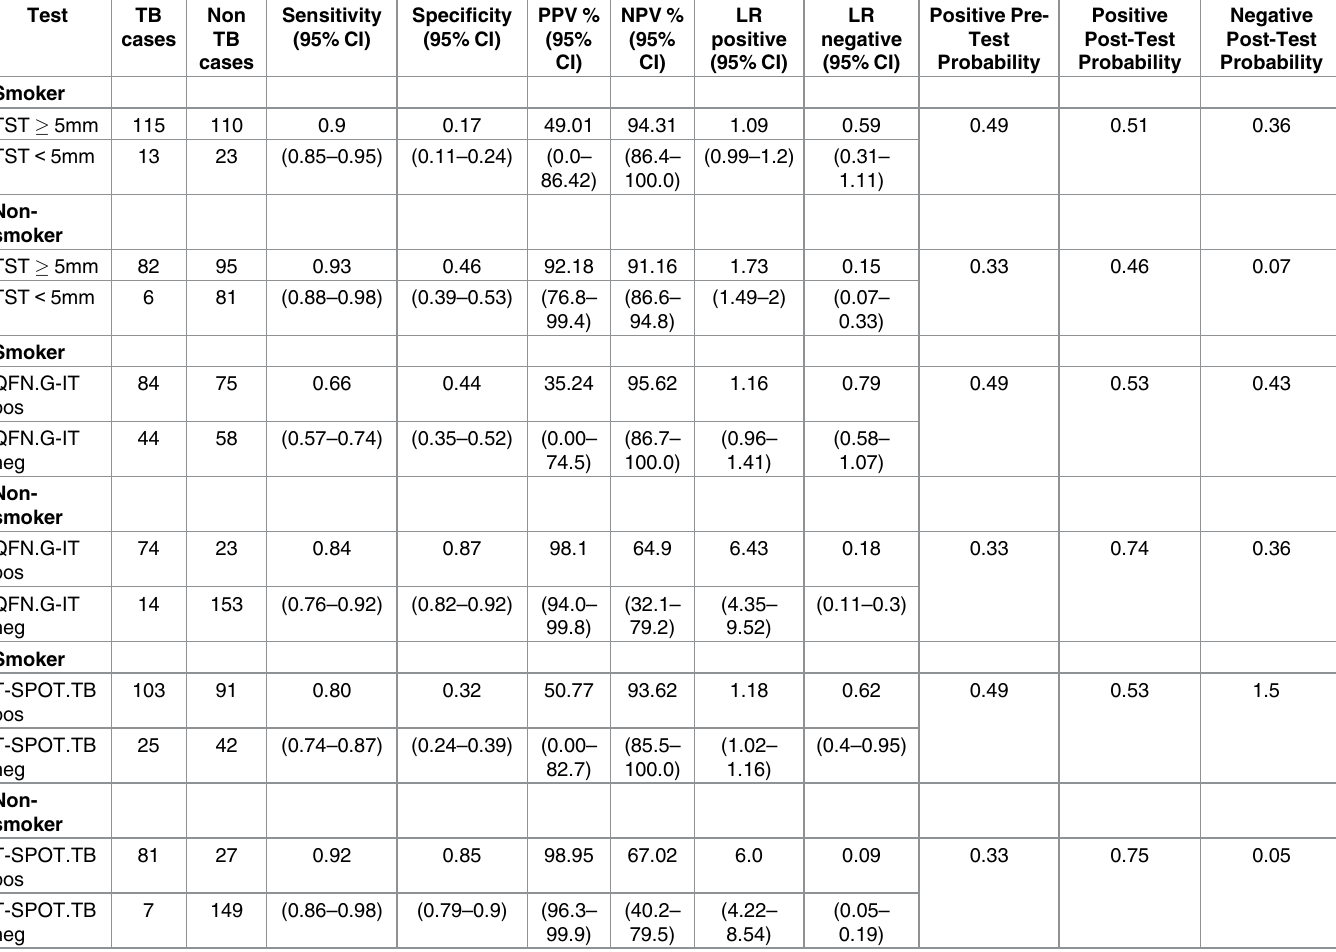
Table 4. Likelihood ratios, pre- and post-Test probabilities of TST, QFN-G-IT and T-SPOT.TB in smoker and non-smoker